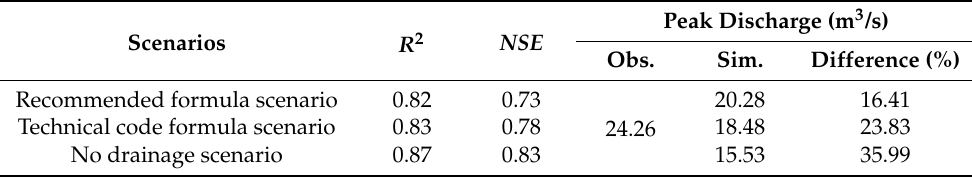
Table 6. Performance of the model under the 3